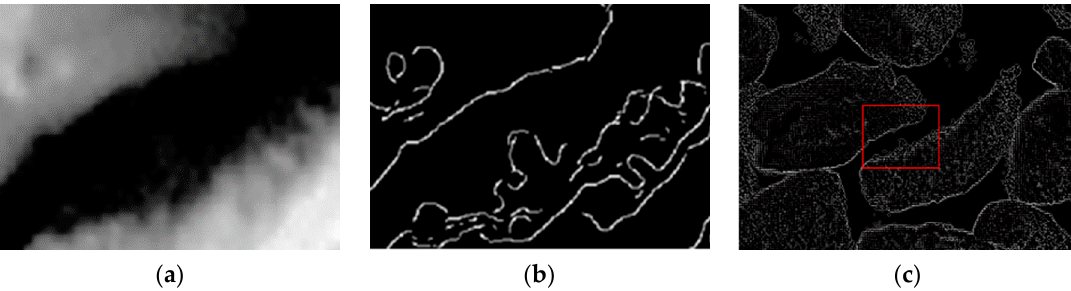
Figure 8. The original zoomed sample image of Figure 7d with two visible grains ( a ), corresponding edge image after Gaussian smoothing and Canny detection ( b ), calculated second derivative, part of ( a ) marked with red color ( c ).